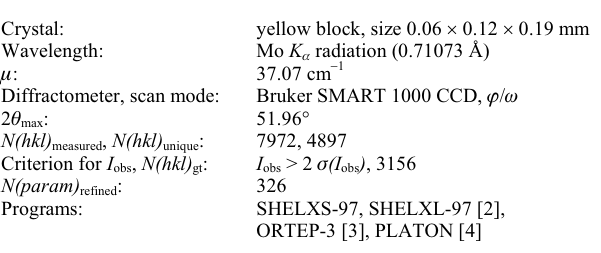
Table 1. Data collection and